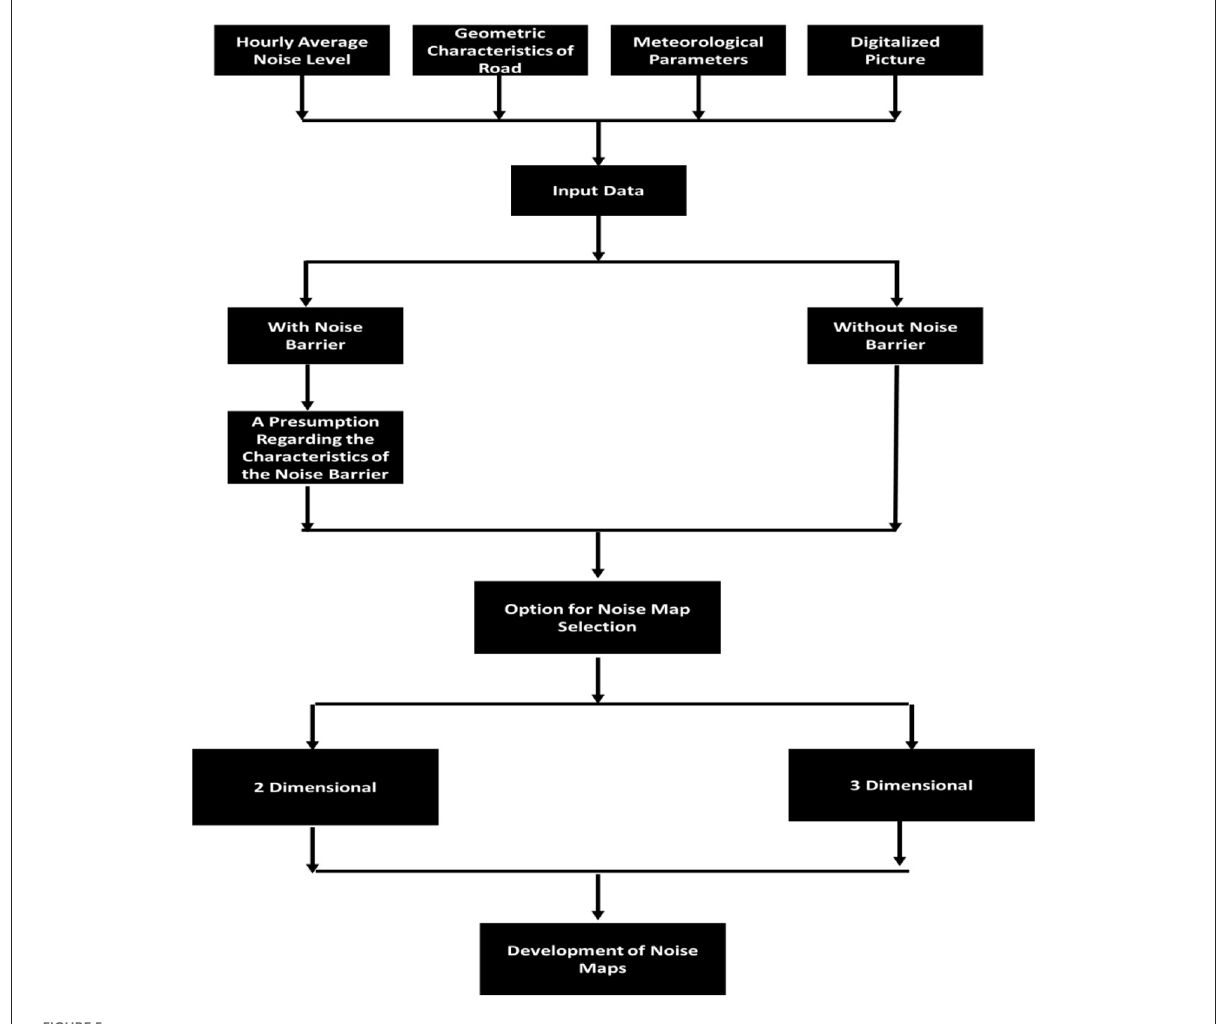
FIGURE5 Flow chart of 2D noise